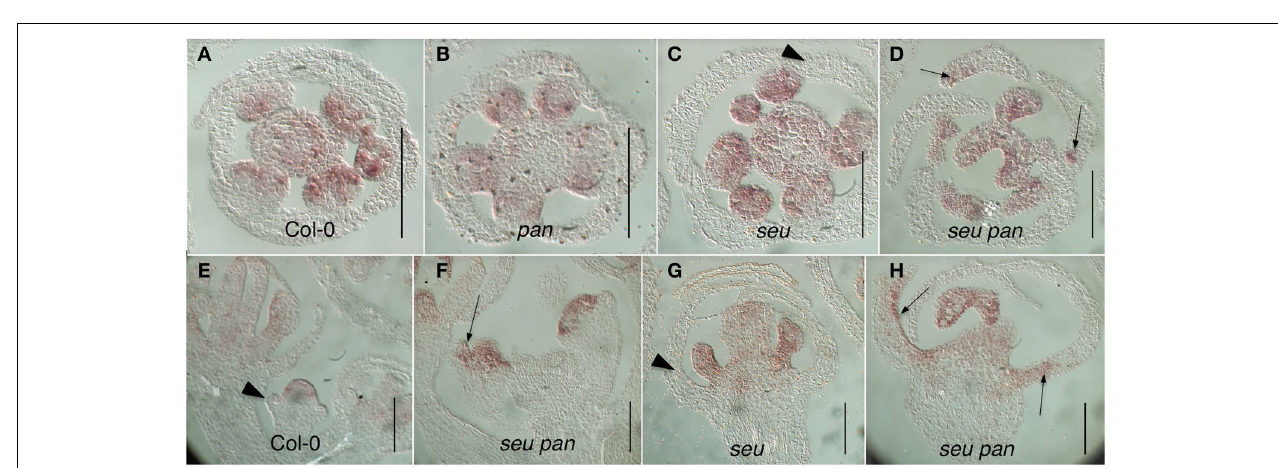
FIGURE 5 | Ectopic AG expression in the seu pan double mutants. (A–D) Floral cross sections (E–H) Floral longitudinal sections. Arrowheads indicate sepals within which AG expression is not detected. Arrows indicate sepals within which ectopic AG expression